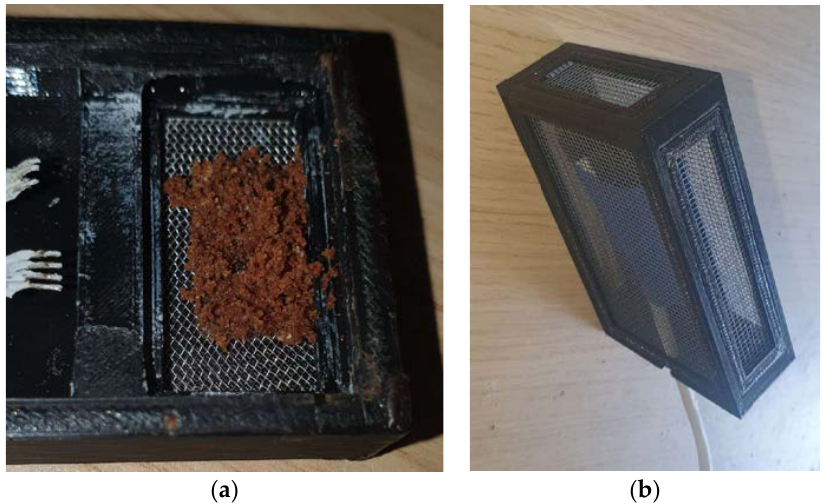
Figure 9. ( a ) the bees covering the gas sensor with propolis on the left. We left only partial coverage as it was totally covered. ( b ) new, gas-penetrated box houses the gas sensor and placed in the beehive in such a way that not all sides can be covered by propolis.